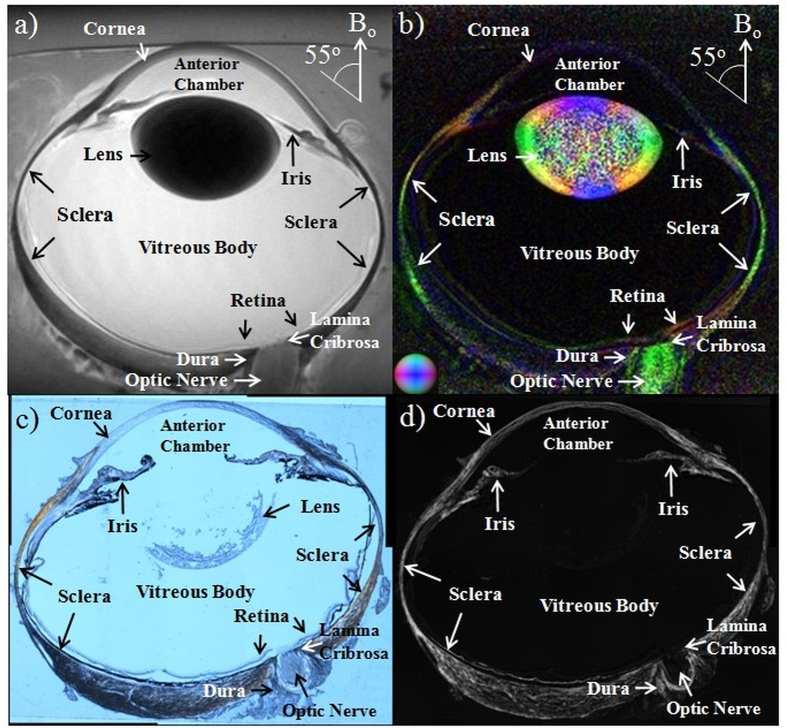
Whole eye imaging and histological confirmation.Representative (a) T2-weighted MRI, (b) color-encoded fractional anisotropy map in diffusion tensor MRI (DTI), (c) histological section imaged with polarized light microscopy, and (d) energy, or intensity-map of the collagen density parallel to the plane of the section, calculated from a series of polarized light microscopy images of the unloaded ovine eye. (Color representations for the principal diffusion directions in the color-encoded fractional anisotropy map: Blue: caudal-rostral; red: left-right; green: dorsal-ventral) (Bo: main magnetic field).